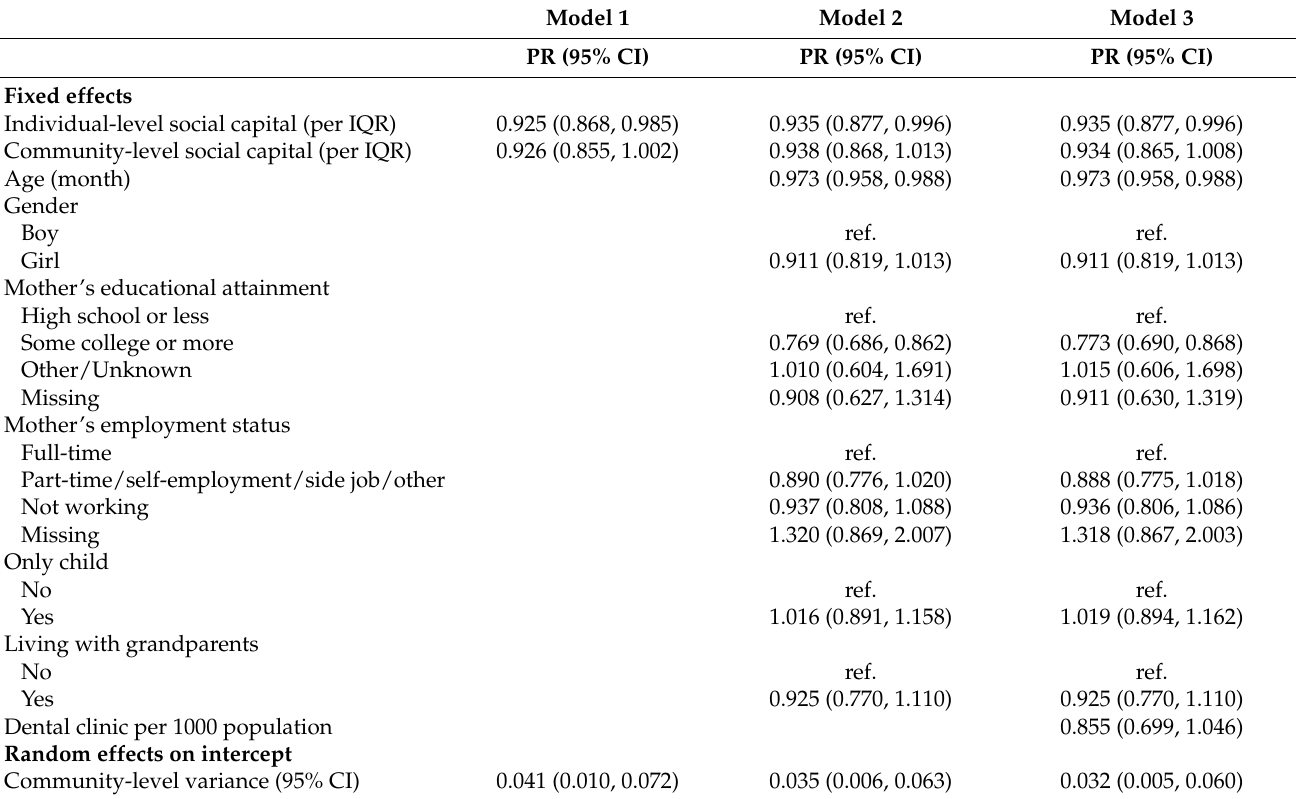
Table 2. Association between social capital and access to dental check-ups of children;